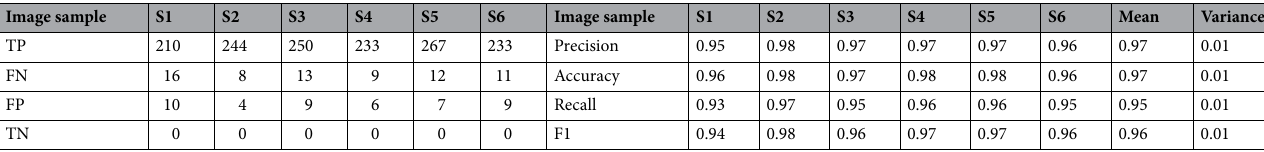
Table 1. Precision of rice cluster recognition.